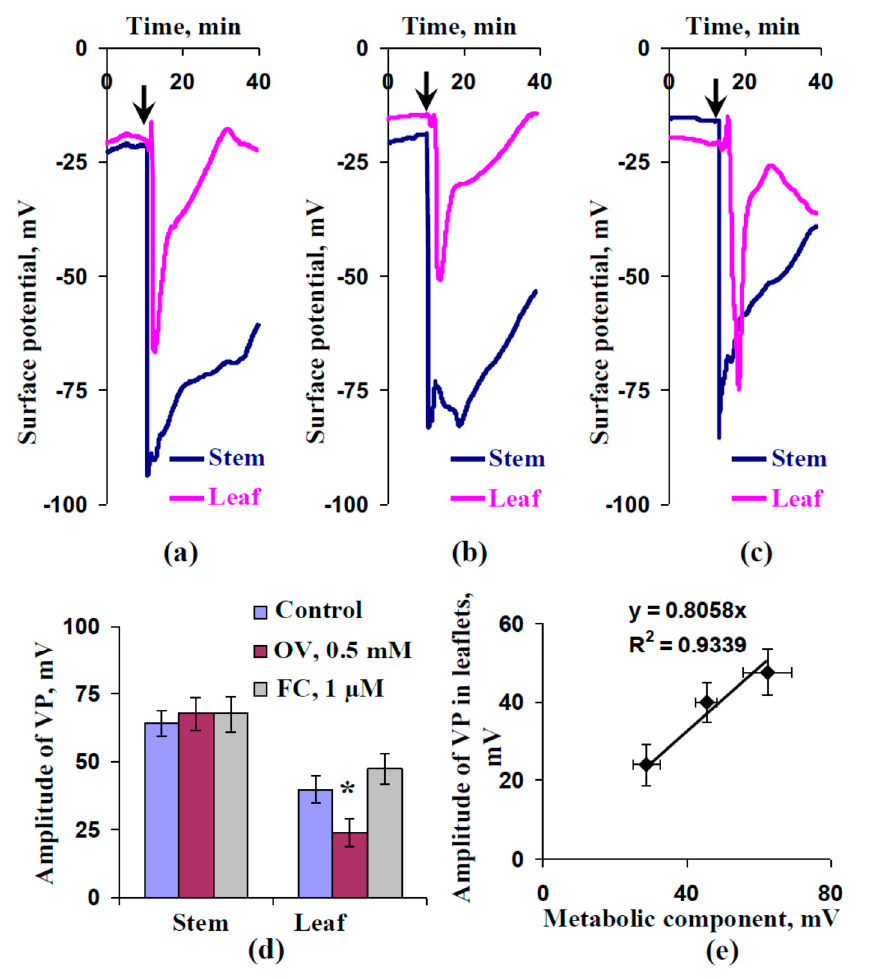
Figure 2. Examples of variation potential (VP) measurements in pea seedlings under control conditions ( a ) and after preliminary treatment by sodium orthovanadate (OV) ( b ) or fusicoccin (FC) ( c ); average amplitudes of VP ( d ) ( n = 6–15) and scatter plot between values of the metabolic component and VP amplitudes in leaflets ( e ). The preliminary OV (0.5 mM) and FC (1 µM) treatment of the second mature leaves in seedlings was performed by incubation of the leaf (2 h) in solutions of these chemical agents; after that, these leaves were dried using filter paper and used for the extracellular measurement of electrical activity. OV and FC were dissolved in standard solution (1 mM KCl, 0.5 mM CaCl 2 , and 0.1 mM NaCl). Similar incubation in the standard solution was used as the control. The arrows mark the local burning of the first mature leaf (flame, 2–3 s). Extracellular measurements of surface potentials were recorded in the second leaves and in the stems near these leaves. The values of the metabolic component were taken from Figure 1. *, statistically significant difference between experiment and control plants ( p < 0.05). R 2 , determination coefficient.